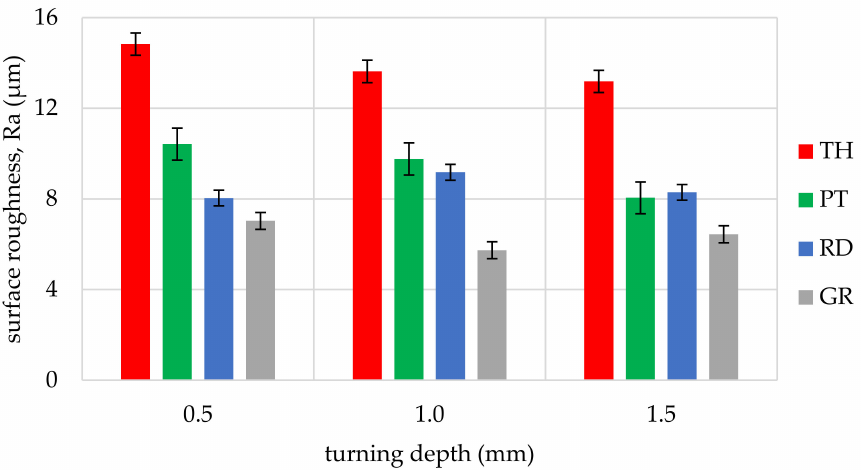
Figure 9. Influence of turning depth and type of cutting insert on surface roughness of Beechwood, Fagus sylvatica (BeW).